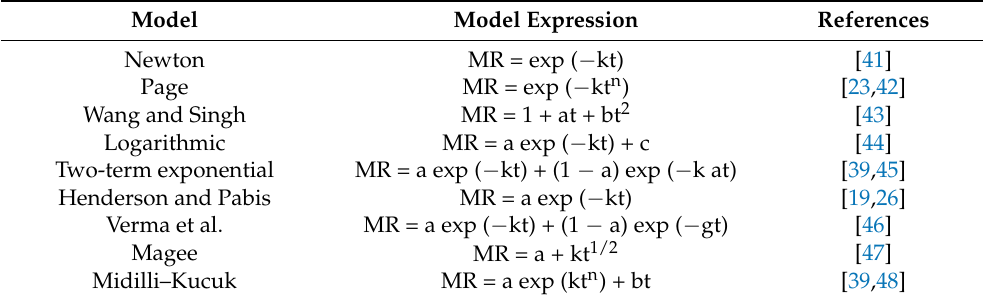
Table 1. Mathematical models fitted to the thin layer drying curves of Moringa oleifera leaves. Model Model